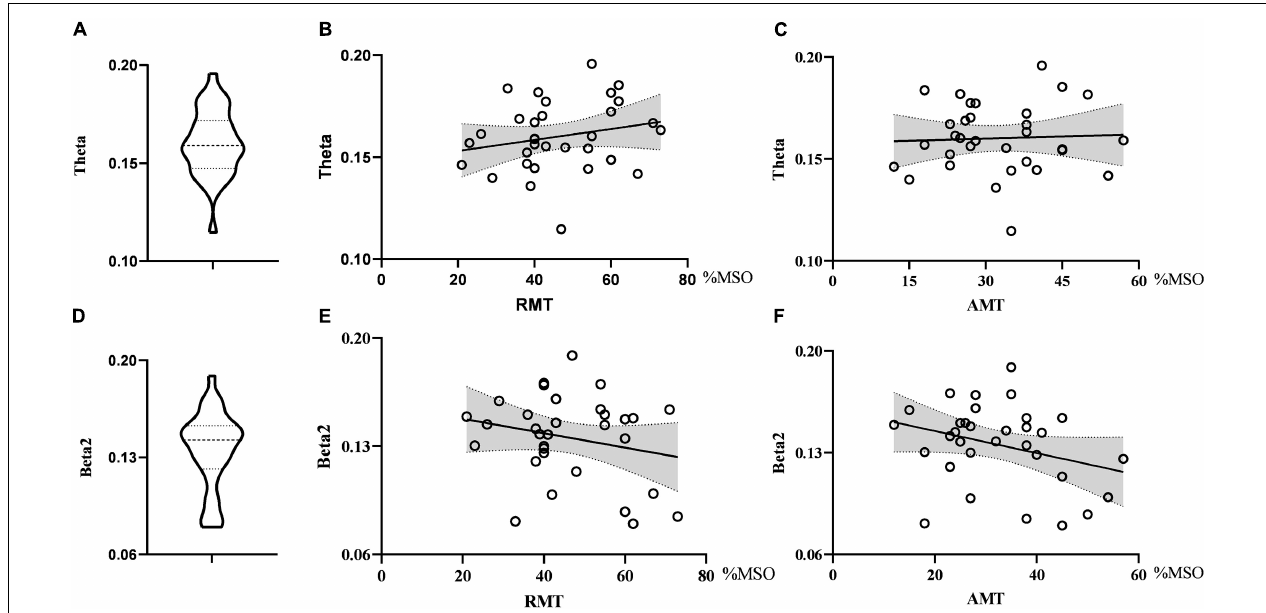
FIGURE 4 | Violin diagrams and scatter diagrams. Violin diagrams showed the distribution of clustering coefficient in theta and beta2 band (A,D) . Scatter diagrams showed the correlation between clustering coefficient and motor threshold (B,C,E,F)